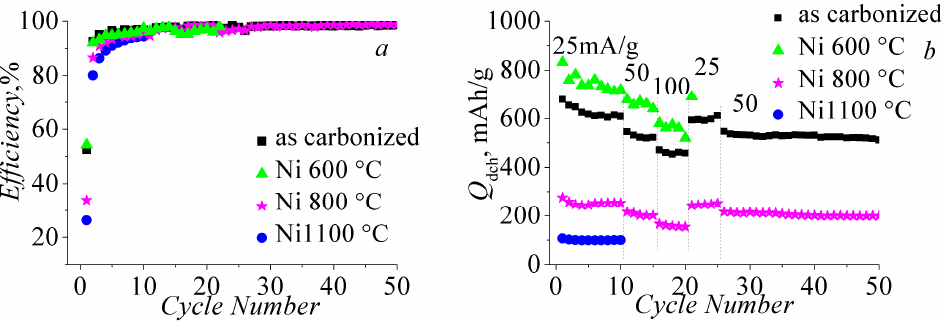
Figure 12. Coulombic efficiency ( a ) and discharge capacity at different currents on the cycle number for as carbonized and nickel-containing electrodes ( b ).